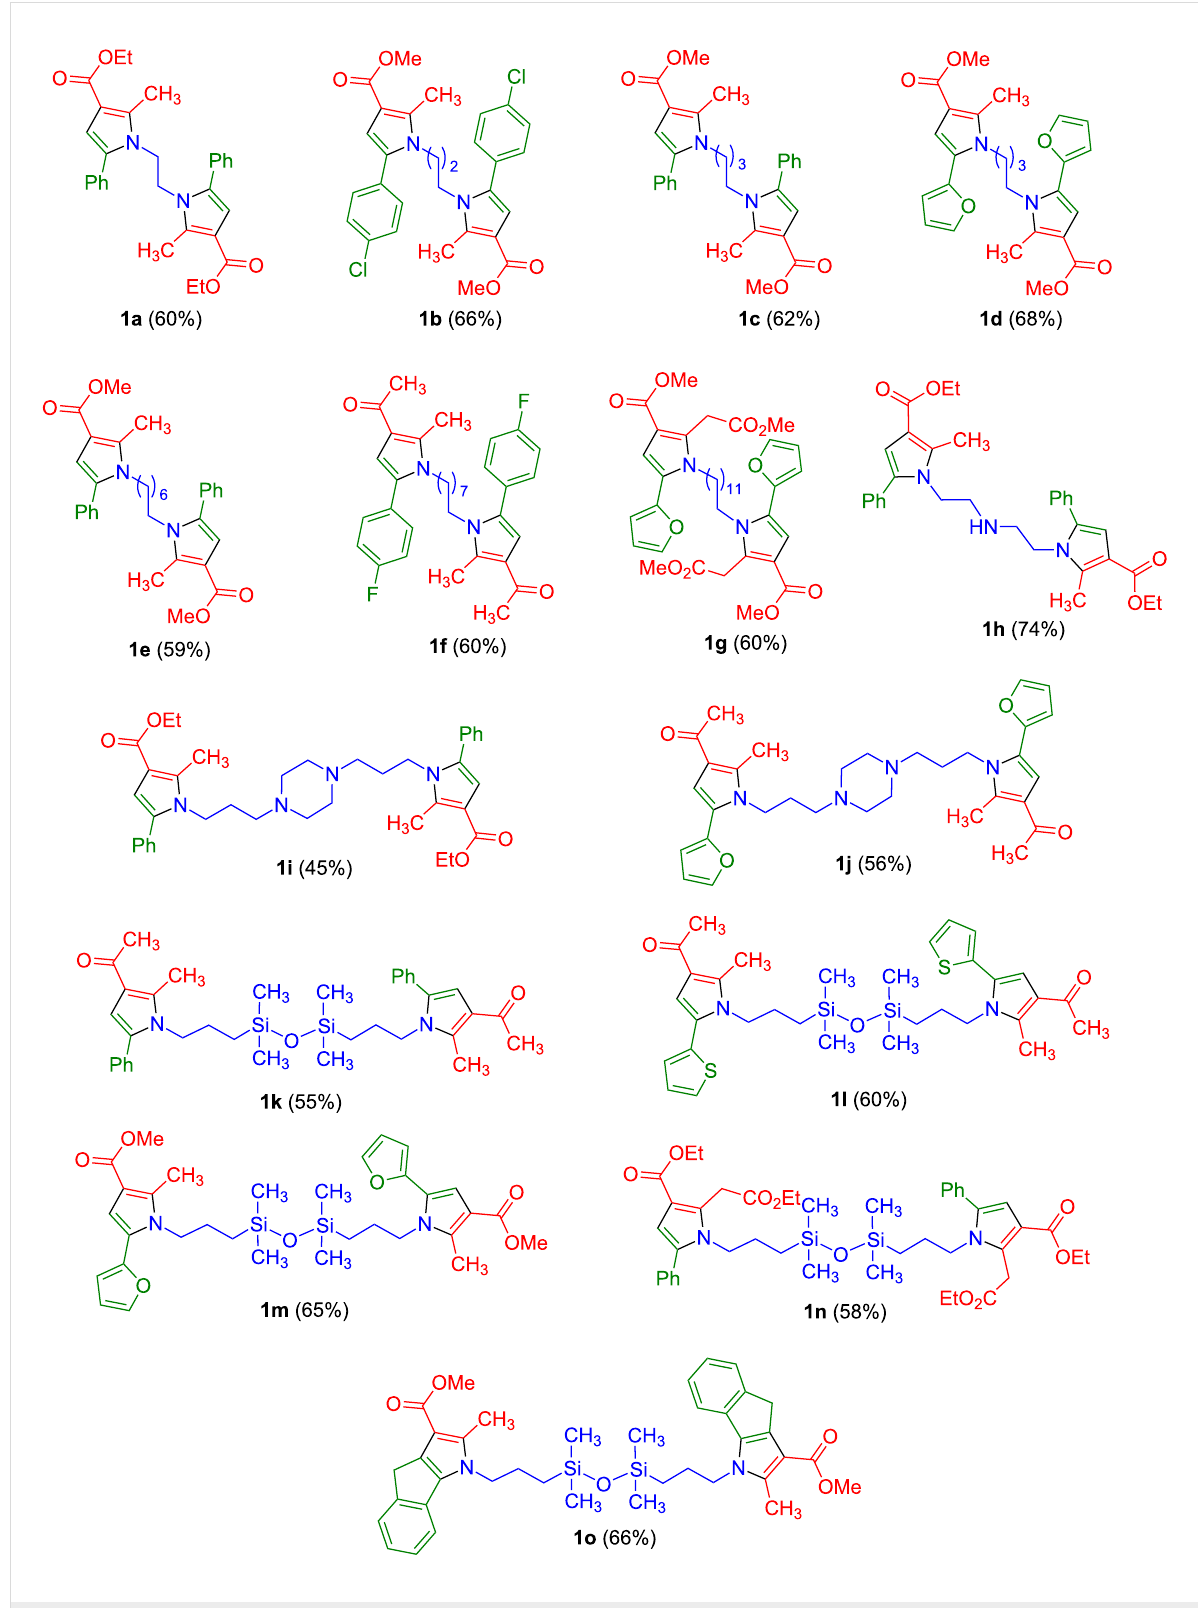
Figure 1: Scope of the synthesis of symmetrical bispyrrole